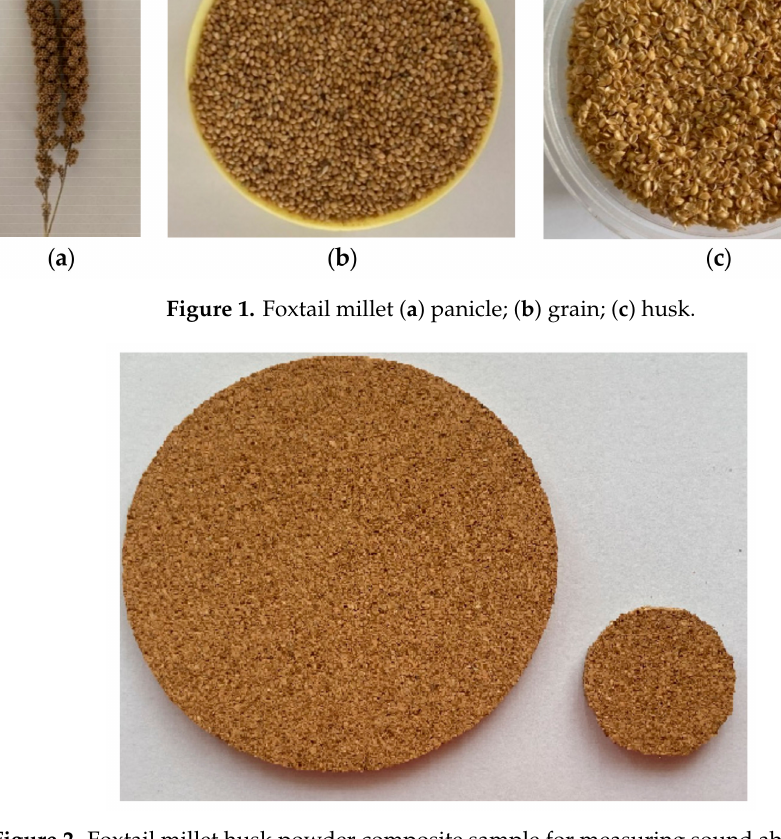
Figure 2. Foxtail millet husk powder composite sample for measuring sound